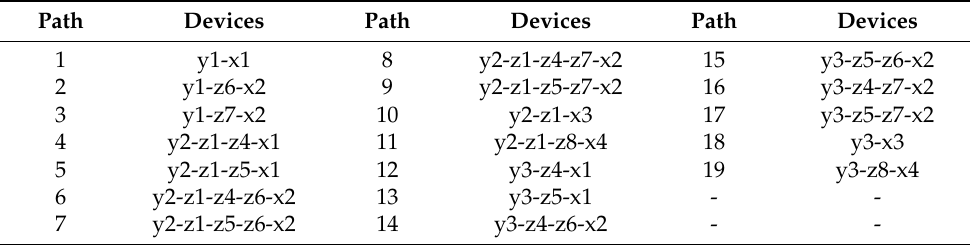
Table 5. Transmission paths in the five-bus system. Path Devices Path Devices